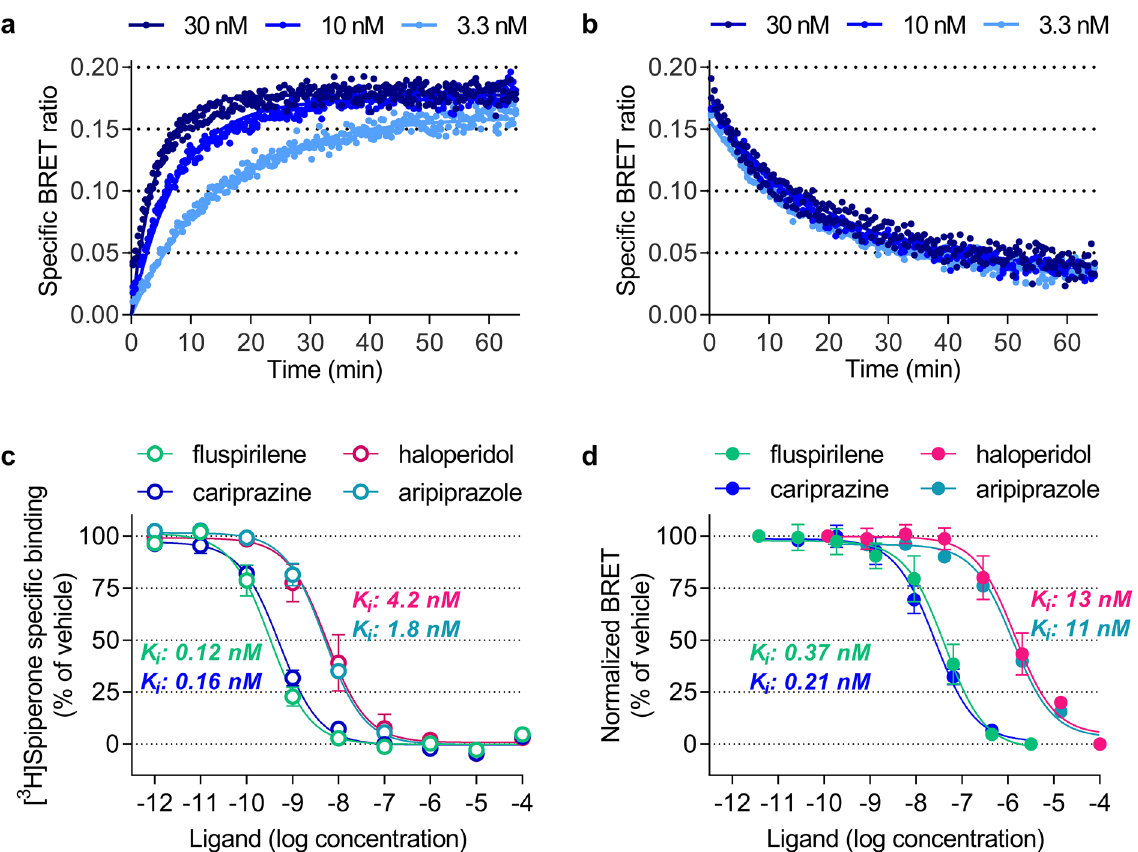
Figure 6. Kinetics of fluorescent ligand 10a at D 3 R and competition binding experiments. ( a ) Association of 10a at room temperature was measured by NanoBRET using secNluc-D 3 R membrane preparations and threefold serial dilutions of 10a (3.3–30 nM). ( b ) Dissociation of 10a was initiated by addition of 10 μM haloperidol after equilibrium had been reached. Data show duplicates of an individual representative experiment. ( c , d ) Competition binding curves for reference antipsychotics obtained with ( c ) the radioligand [ 3 H]spiperone and membranes from HEK293T cells expressing wtD 3 R receptors or ( d ) 100 nM fluorescent ligand 10a and secNluc-D 3 R membranes. Obtained IC 50 values were transformed into K i values applying the equation of Cheng and Prusoff 52 . Data show mean ± SEM of n = 4 independent